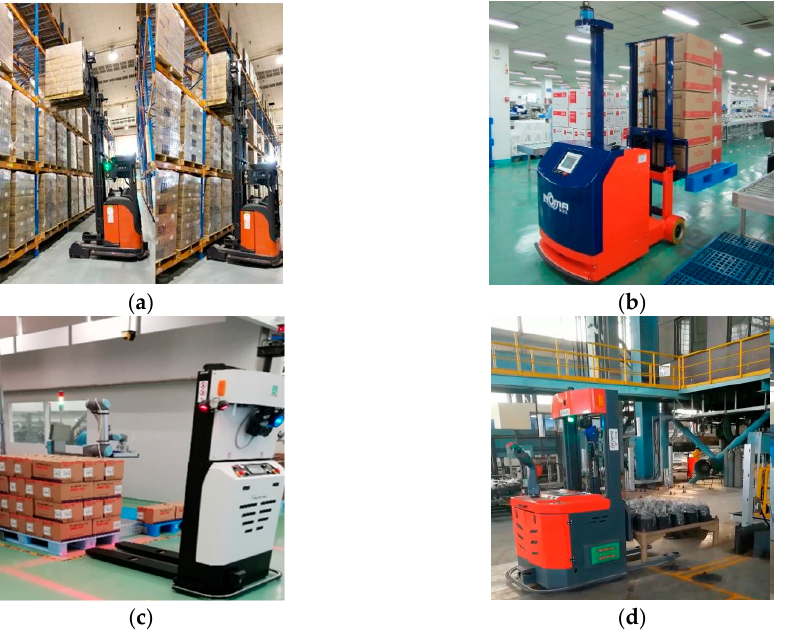
Figure 1. The specific pallet detection scene for automated guided vehicles. ( a ) Storage shelves, ( b ) the production workshop, ( c ) drug transport and ( d ) blast furnace conditions.